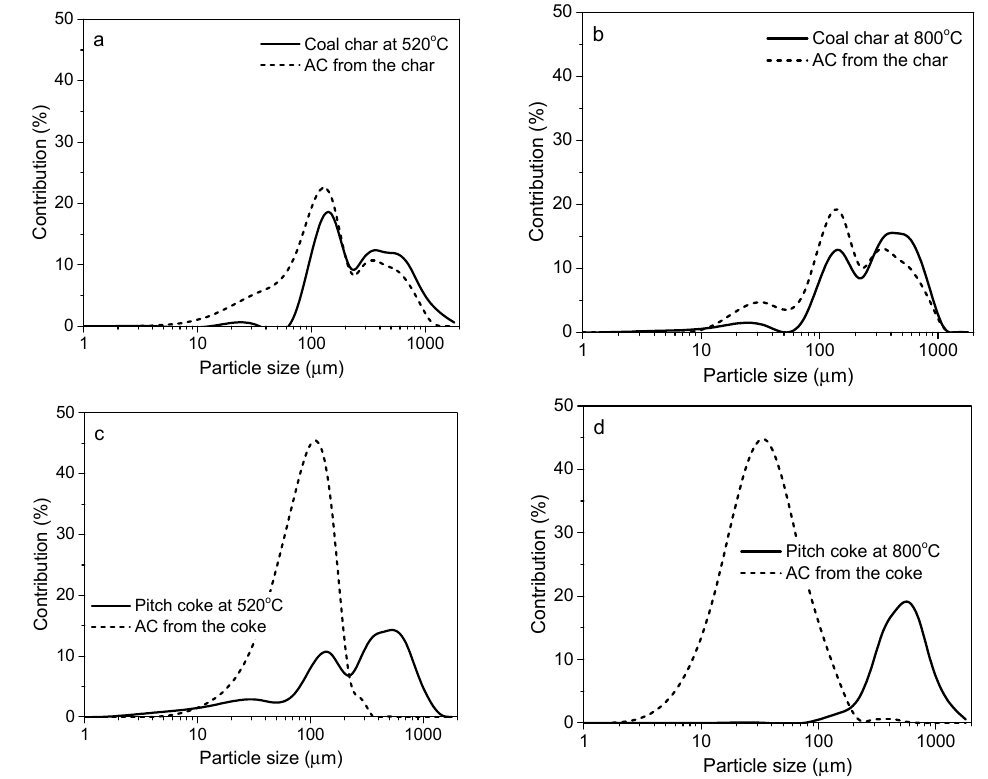
Figure 9. Particle size distribution of the char/cokes from bituminous coal ( a , b ) and coal-tar pitch ( c , d ) and resultant ACs produced by KOH activation. Precursor/KOH ratio 1:3, reaction temperature 800 °C, soaking 1 h.